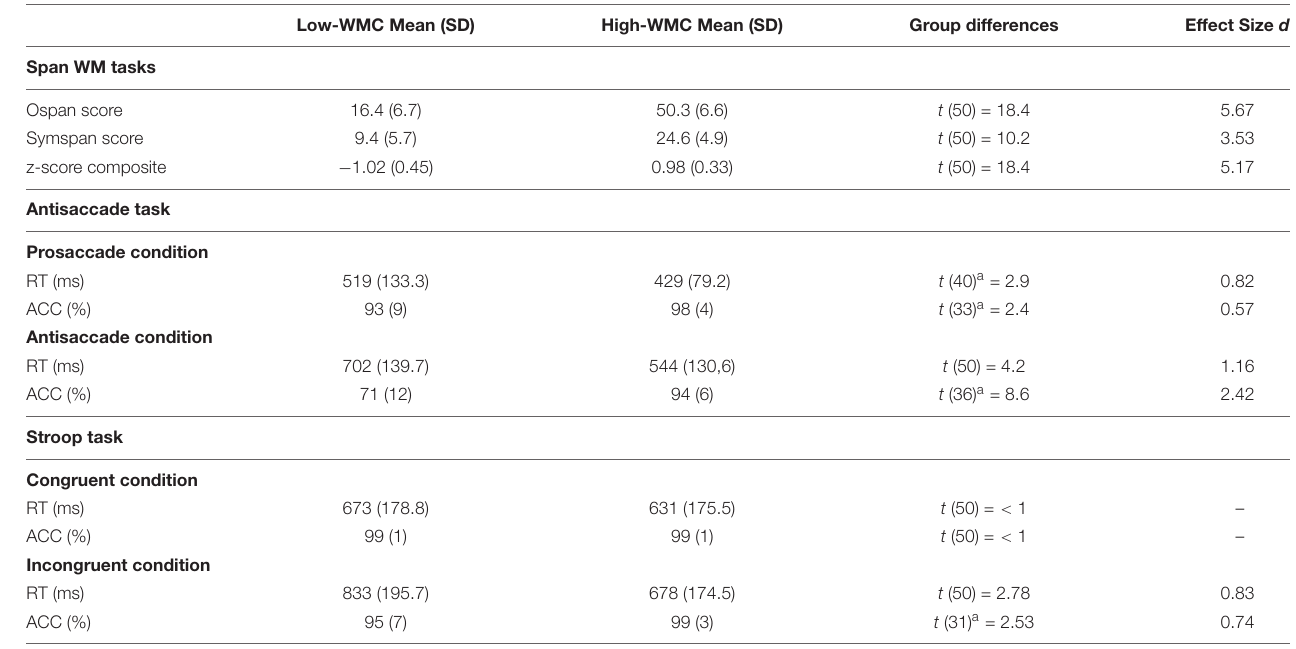
TABLE 1 | Summary statistics for performance in the complex span WM tasks (Ospan, Symspan, and z-score global composite) and attentional control tasks (antisaccade and stroop congruency) by Low-WMC and High-WMC